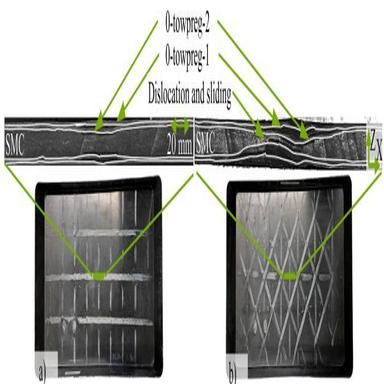
Illustration of one periodic 0-towpreg waviness zone of 0/90 (a) and combined design (b) including cross-section. (0-towpreg-1 and − 2 meaning the 0-towpreg at the skin and inner part, respectively).